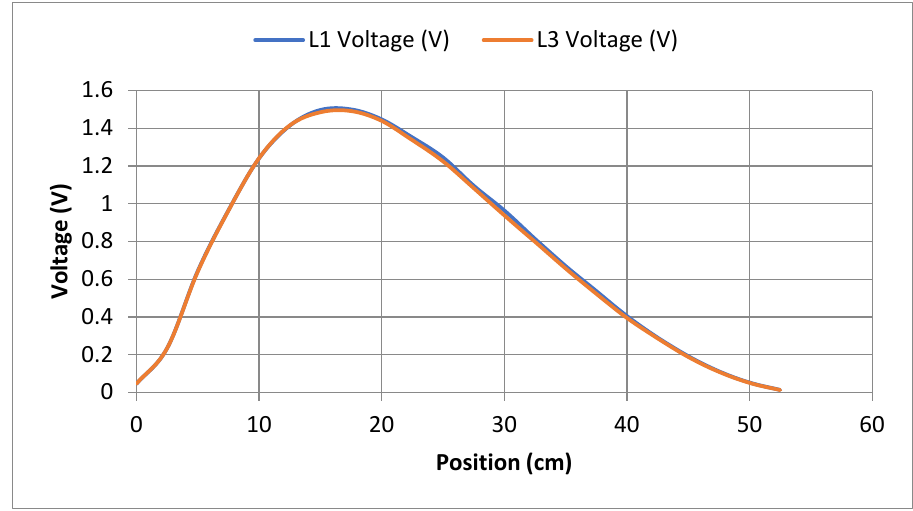
Figure 6. L1 and L3 sensors’ voltage reading in terms of load position.